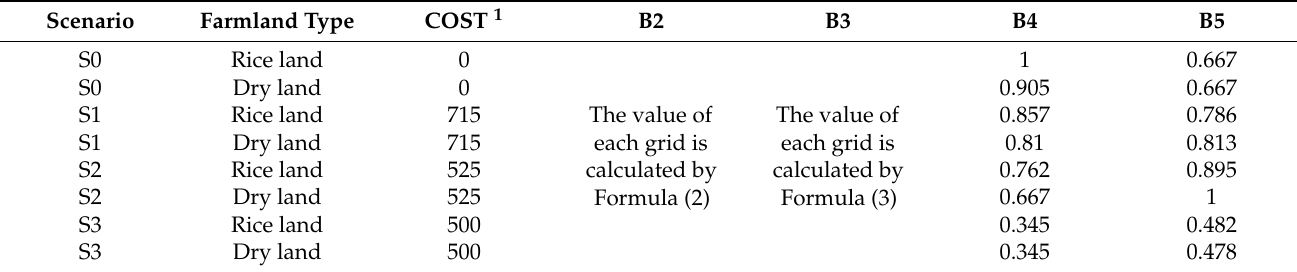
Table 3. Input values of indicator layer of different types of land use in different scenarios. S0: current situation; S1: halving fertilization every year; S2: fallow every other year; S3: returning agricultural land to forest; B2: low-nitrogen degree of water; B3: low-phosphorus degree of water; B4: farmland income; B5: farmers’ participation